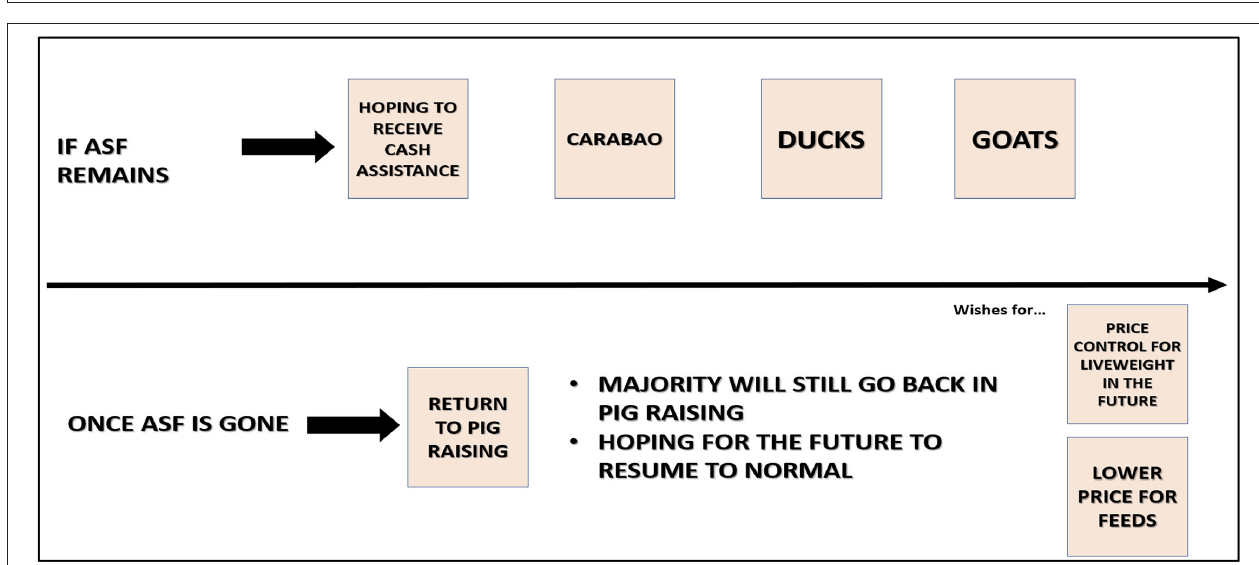
FIGURE 7 | Timelines for African Swine Fever disease events beginning in December 2019, produced during two focus group discussions in Camarines Sur by male (top) and female (bottom) farmers of fewer than 10 pigs.